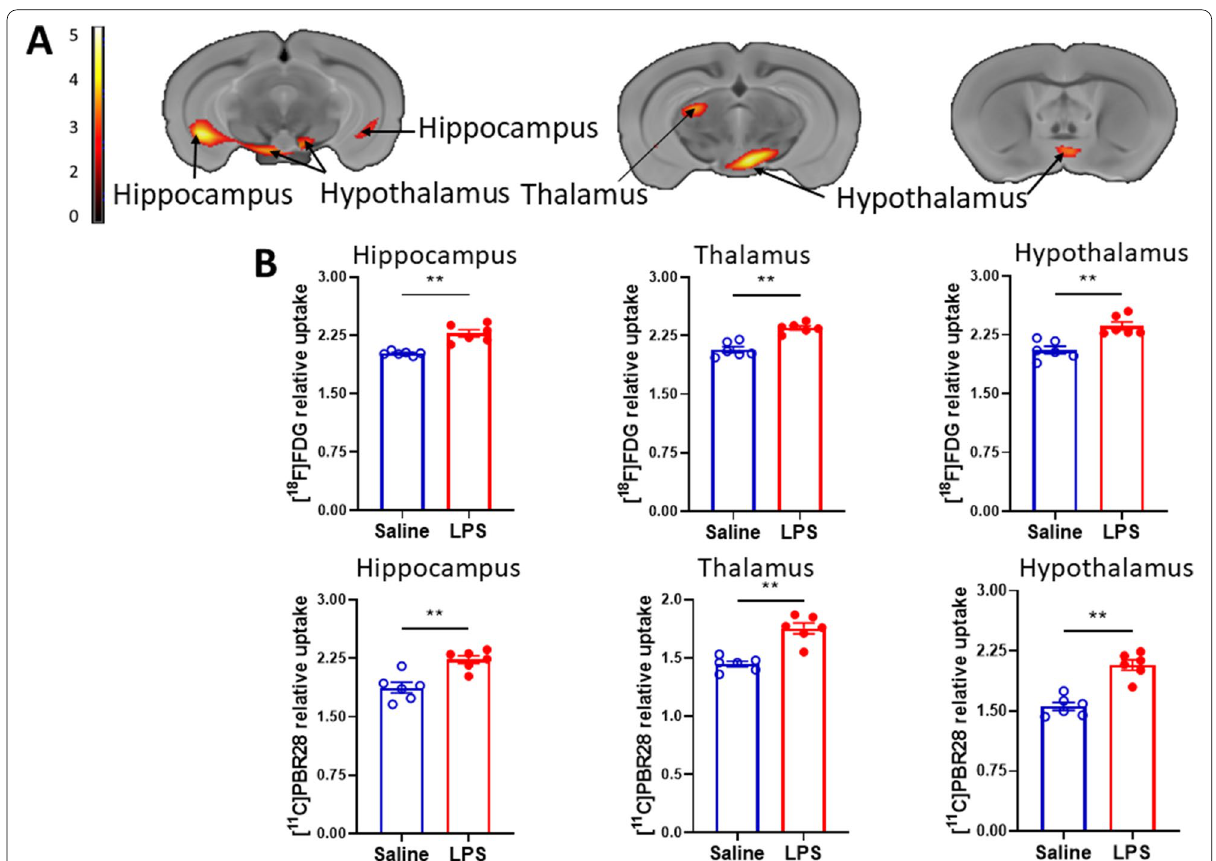
Fig. 1 Brain regions with overlapping increases in [ 11 C]PBR28 and [ 18 F]FDG uptakes during endotoxemia. A Dual tracer conjunction increases in metabolism and microglial activation (TSPO binding). Brain coronal sections of statistically significant clusters (color bar represents t‑value height, extent threshold T 2.85), overlaid onto MRI atlas for visualization. Statistically significant clusters ( P < 0.005) show overlapping regions of increased = uptake of [ 11 C]PBR28 and [ 18 F]FDG in the hippocampus, the thalamus, and the hypothalamus in LPS administered ( n ( n 6) mice (see Table 1 for stereotaxic coordinates). B Post‑hoc analysis for the same statistically significant increases in metabolic activity [ 18 F]FDG = and microglial activation [ 11 C]PBR28 (TSPO binding) in saline ( n Methods for